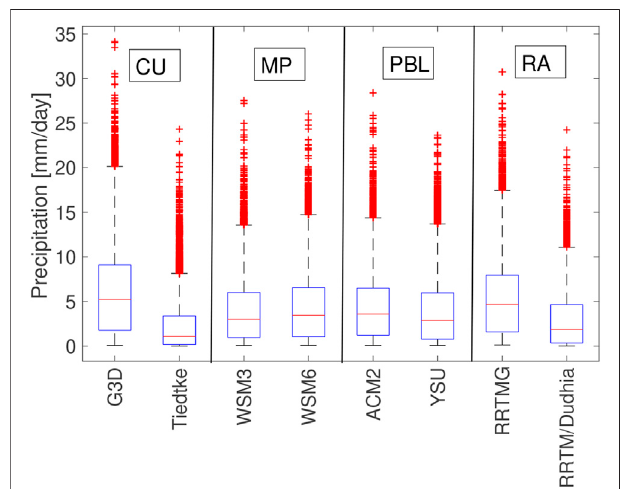
FIGURE 2 | Simulated subgroup-ensemble distributions of mean daily precipitation values for the period 2006 – 2010. Each box-whisker plot represents the distribution within the NSSA domain for each subgroup- ensemble. Each subgroup-ensemble consists of eight ensemble